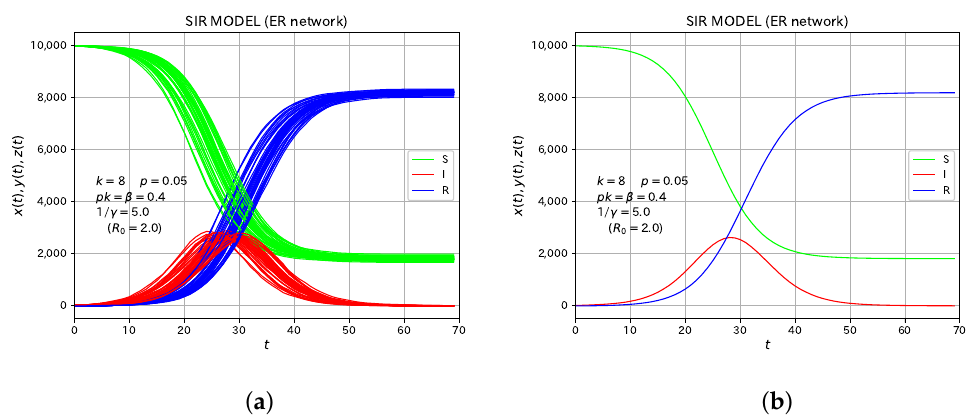
Figure 8. The simulational results of the microscopic SIR model on the ER network. Initially, 10 individuals were set to be infected. Initial values are x ( 0 ) = 9990, y ( 0 ) = 10, and z ( 0 ) = 0. ( a ) All the results of 40 samples are plotted; ( b ) the average over 40